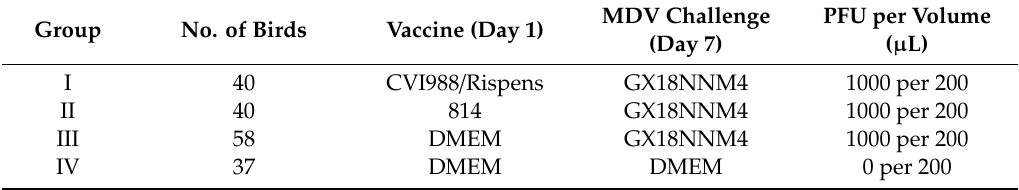
Table 1. The vaccinations and challenges of the experimental groups. Group No. of Birds Vaccine (Day